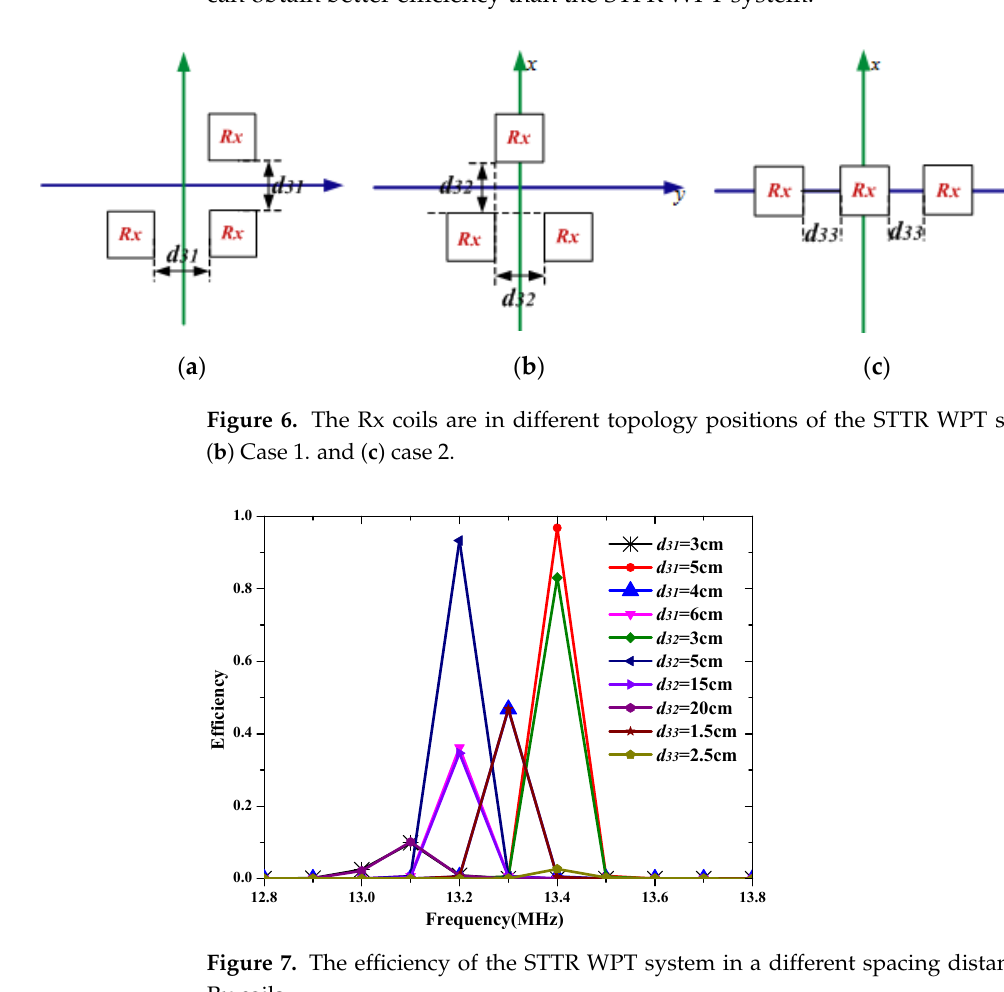
Figure 8. The Rx coils in different topology positions of the STTWR WPT system: ( a ) case 3 and ( b ) case 4.